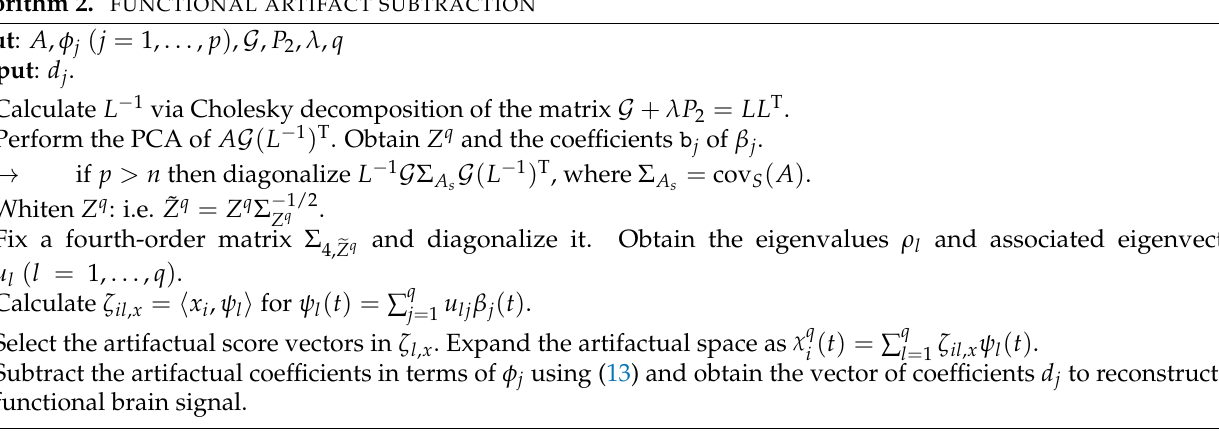
Algorithm 2. FUNCTIONAL ARTIFACT